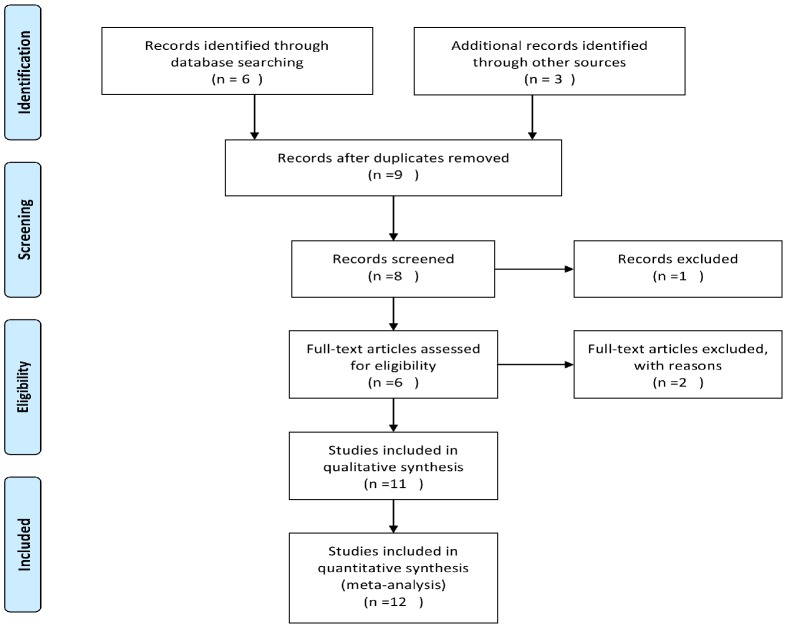
Flow chart of study selection.